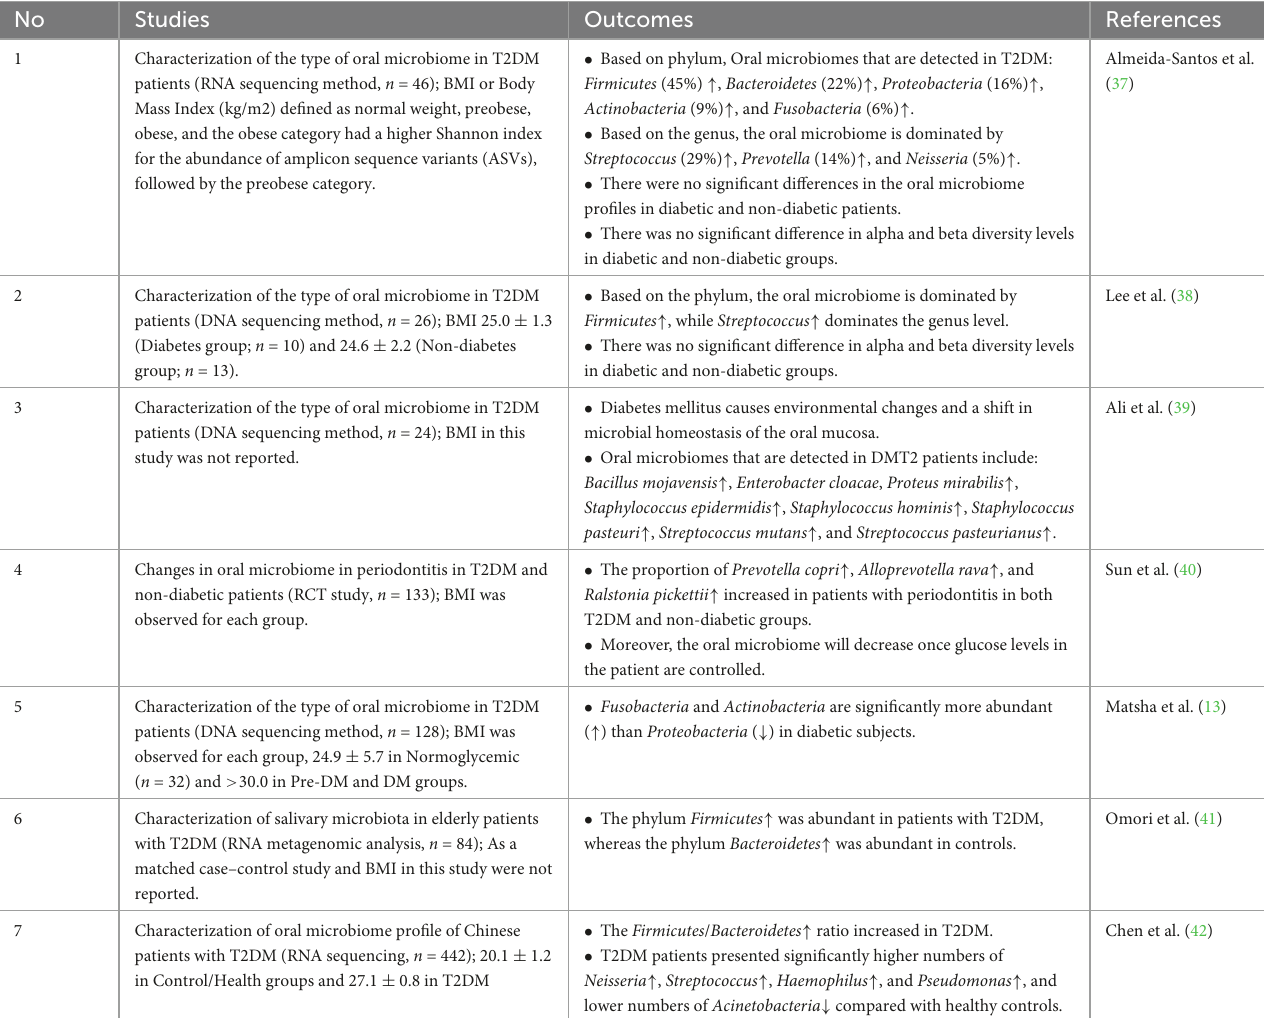
TABLE 1 List of clinical evidence regarding the effectivity of oral microbiome in detecting type 2 diabetes mellitus (T2DM). No Studies